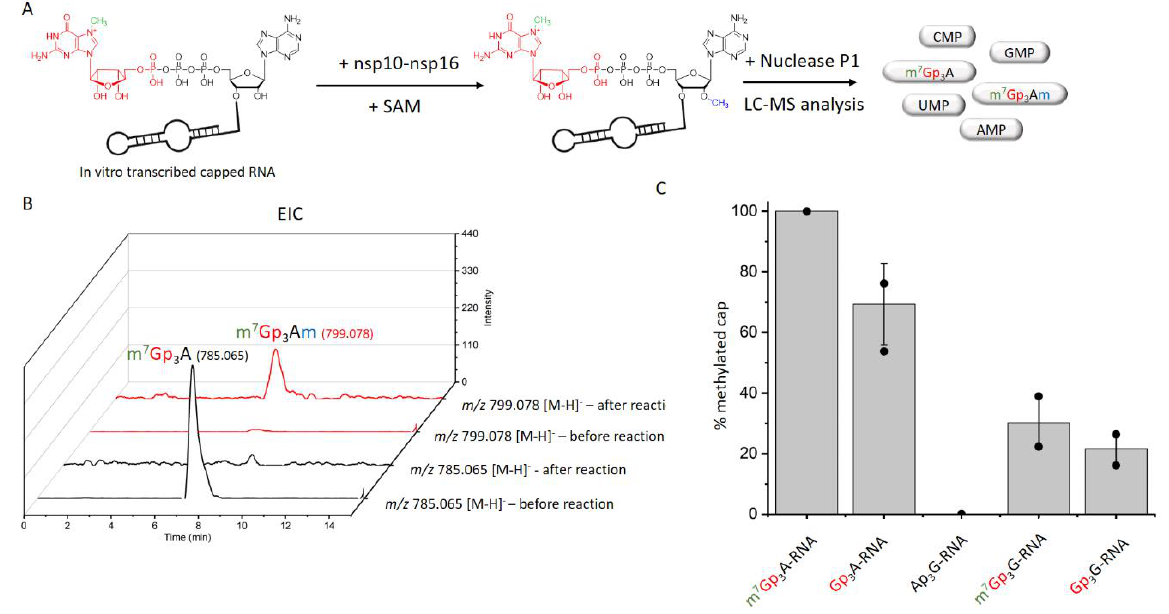
Figure 2. Screening of nsp10-nsp16 activity on non-canonical capped RNA. ( A ) The scheme of experimental set-up. RNA transcribed in vitro was treated by nsp10-nsp16 and SAM, then treated by nuclease P1 and analyzed by LC-MS. ( B ) Extracted Ion Chromatogram (EIC) for m / z 785.065 and m / z 799.078 before and after the reaction with nsp10-nsp16, analyzed with method Z. ( C ) The comparison of nsp10 −nsp16 methylation efficiency of various capped RNAs (after the degradation of ppp −RNA).